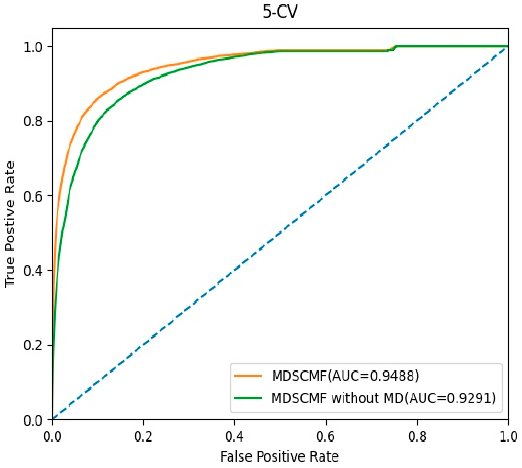
Figure 5. The ROC curves of MDSCMF and MDSCMF without MD.